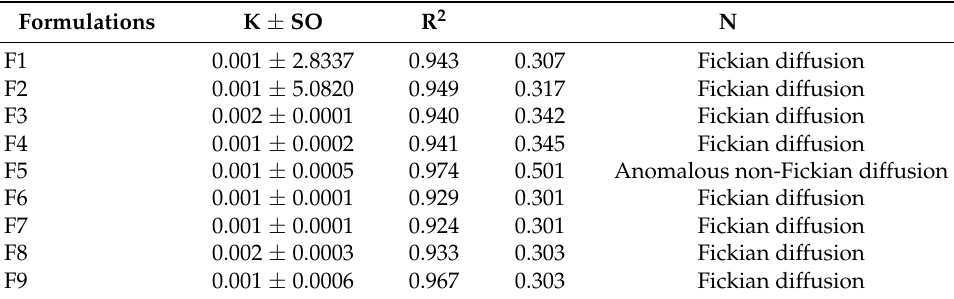
Table 5. Drug release kinetics (F1–F9), Data were expressed as mean ± SD, n =